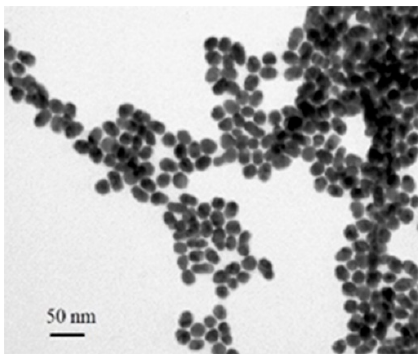
Figure 6. TEM image of PAO-modified GNPs after interaction with Sb 3+ (10 ng/mL).